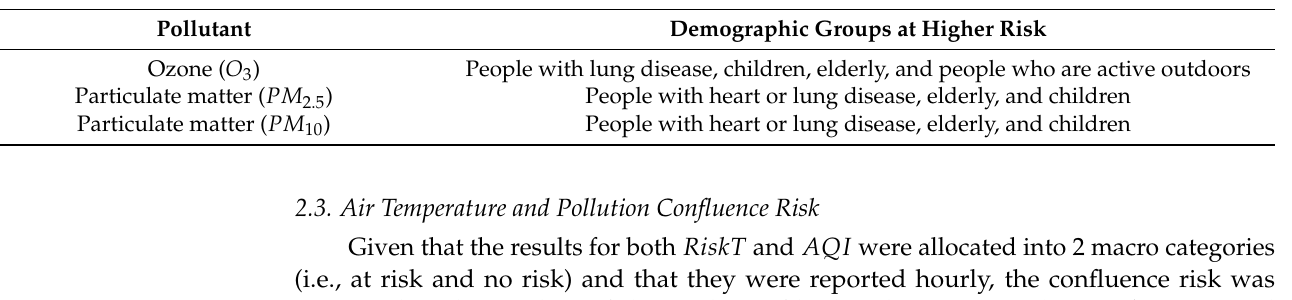
Table 2. Sensitive groups at risk by pollutant type when the AQI goes above 100 for an 8 hour ( O 3 ) or 24 hour ( PM 10 ) average exposure period (extracted and edited from the EPA guidelines